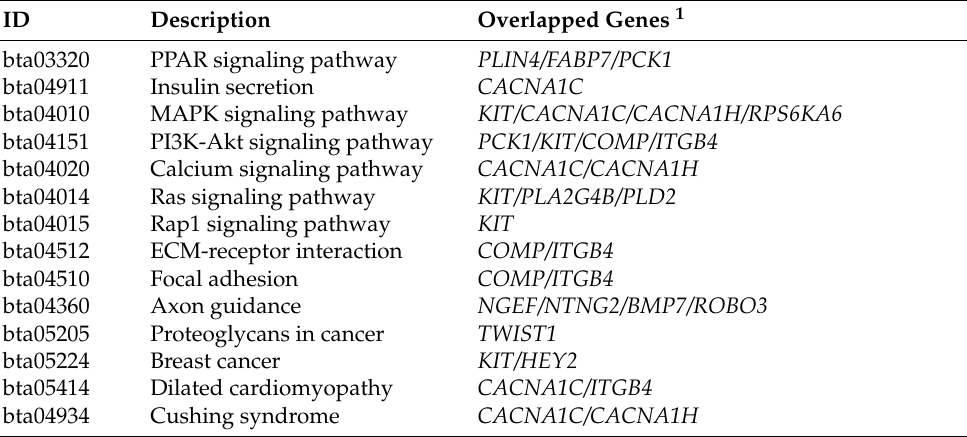
Table 1. The overlapped significant pathways enriched by differentially expressed genes identified in SAT-VAT, SAT-AAT, and VAT-AAT groups.